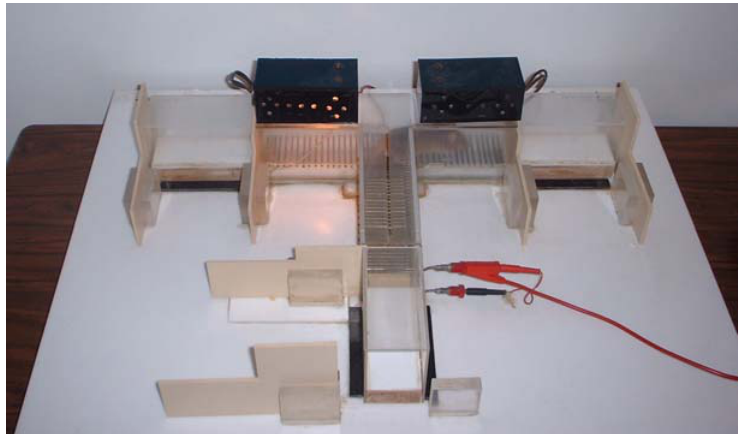
FIGURE 6. Light-dark choice situation in a T-maze . The target arms, left and right, can be lit according to a random sequence so that the mouse learns to choose the dark arms systematically. Complete learning required 60 trials over 6 consecutive days (10 trials per session). (Copyright Venault and Chapouthier,